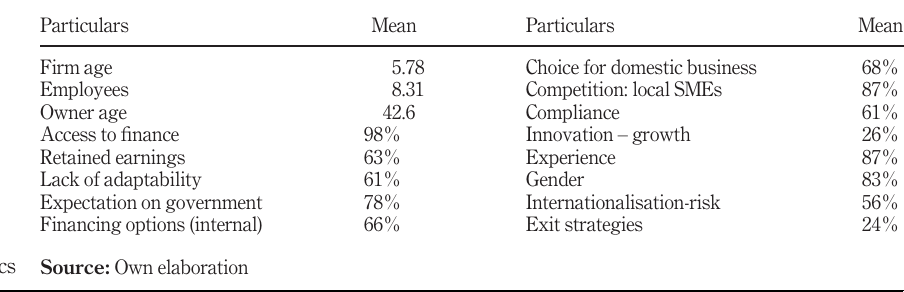
Figure 2. Financing choices based on ethnicity